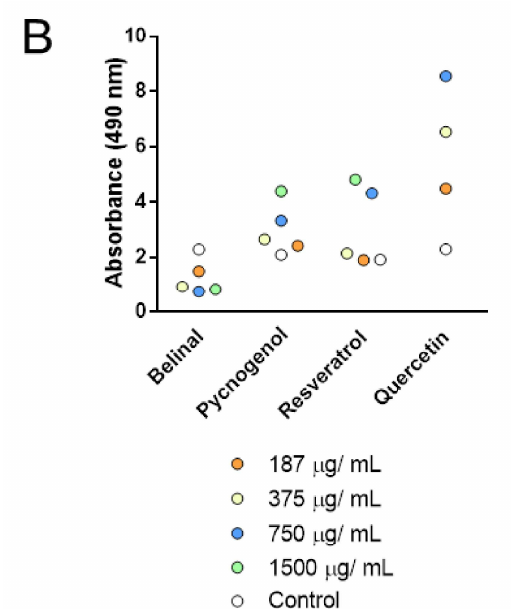
Figure 1. Viability screening to determine the optimal concentration of the polyphenolic extracts and polyphenols for further experiments. Viability of mesenchymal stem / stromal cells (MSCs) was determined for four serial dilutions (1500, 750, 375, 187 µ g / mL) of the polyphenolic extracts and polyphenols (each dot showing the mean of triplicates) using flow cytometry ( A ) and the MTS assay ( B ) after 7 days of treatment. Controls were incubated in cell medium with no additions. ( A ) Top: proportions of single live cells. Middle: flow cytometry gating strategy. Bottom: representative dot plots for viability staining for each polyphenolic extract and polyphenol at 375 mg / mL. The highest concentration of the polyphenolic extracts and polyphenols (1500 µ g / mL) showed significant reductions in the proportions of single live cells compared to controls (one-way ANOVA with Bonferroni correction). ( B ) Absorbance for the MTS assay measured at 490 nm. No significant di ff erences are seen between the tested serial dilutions of the polyphenolic extracts and the polyphenols (one-way ANOVA